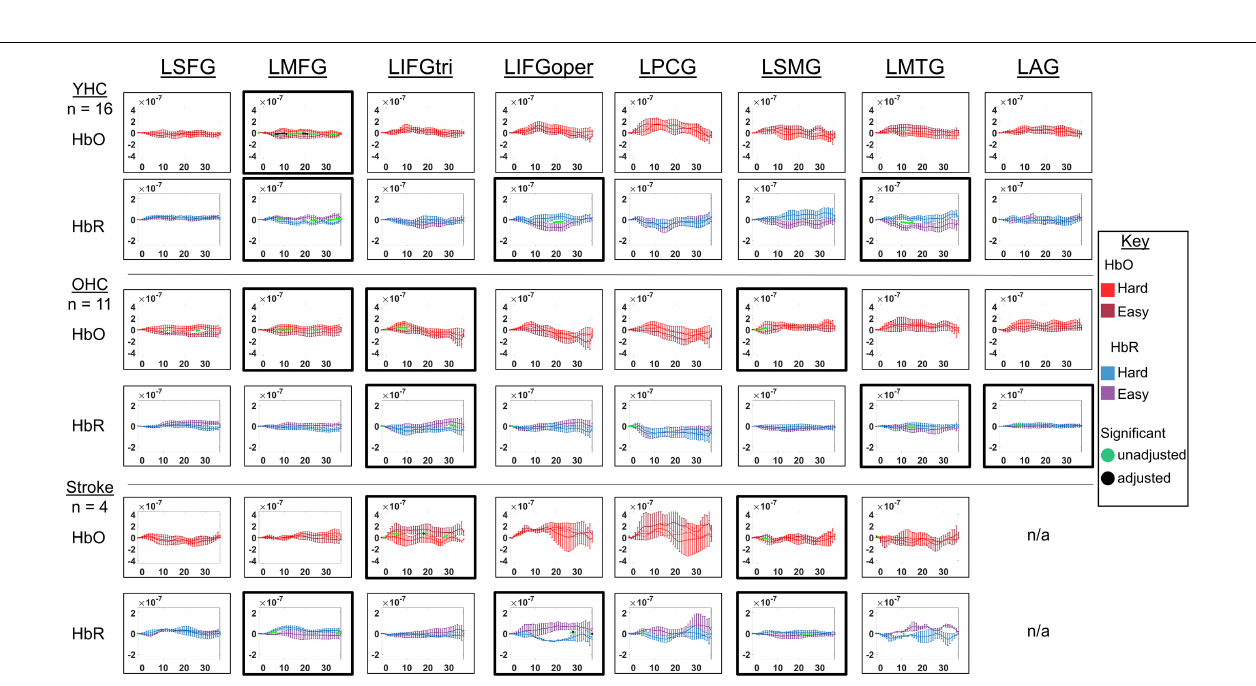
FIGURE 10 | Comparison of group average HRF between task conditions for left hemisphere ROIs during hard vs. easy addition. HbO and HbR changes in µ M units. Significant difference between task conditions at p < 0.05 level are reflected by a green dot and after FDR-adjustment with alpha of 0.05 by a black dot. Black borders denote ROIs for which there was a significant difference between the task conditions for at least three consecutive seconds. When the red line is higher than the maroon line, it suggests there was greater HbO concentration change in the hard than easy addition condition. When the blue line is lower than the purple line, it suggests there was lower HbR concentration change in the hard than easy addition condition. Both patterns are consistent with greater neural activation (i.e., increase in oxygenated blood, decrease in deoxygenated blood) in the hard than easy addition and vice versa. LSFG, left superior frontal gyrus; LMFG, left middle frontal gyrus; LIFGtri, left inferior frontal gyrus pars triangularis; LIFGoper, left inferior frontal gyrus pars opercularis; LPCG, left precentral gyrus; LSMG, left supramarginal gyrus; LAG, left angular gyrus; YHC, younger healthy controls; OHC, older healthy controls; HbO, oxygenated hemoglobin concentration change; HbR, deoxygenated hemoglobin concentration change; N/A, not available due to combination of pruned channels due to poor SNR and lesion.